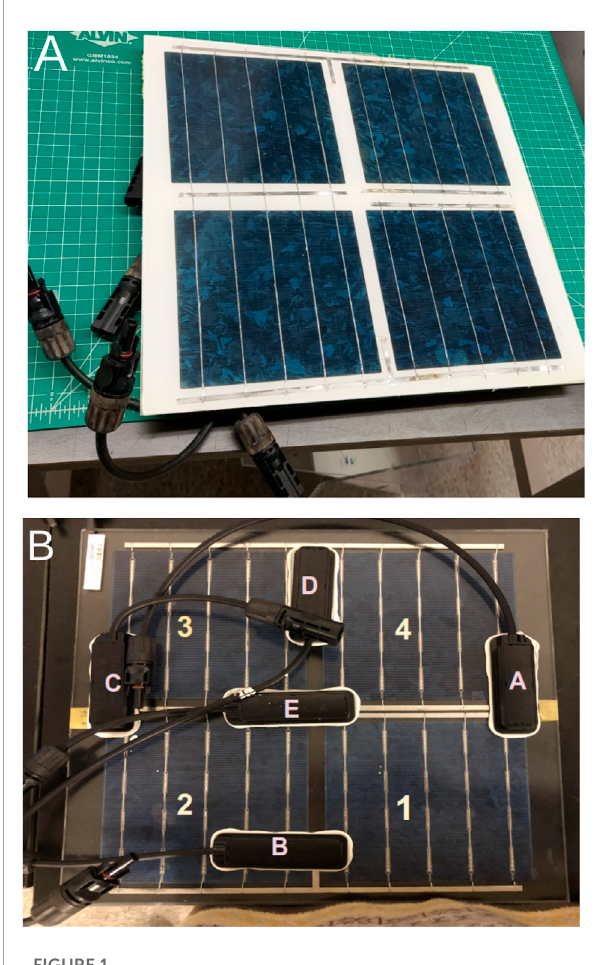
FIGURE 1 Front and rear sides of 4-cell PV minimodules. (A) Front side of GB minimodule. (B) Rear side of DG minimodule with 5 junction